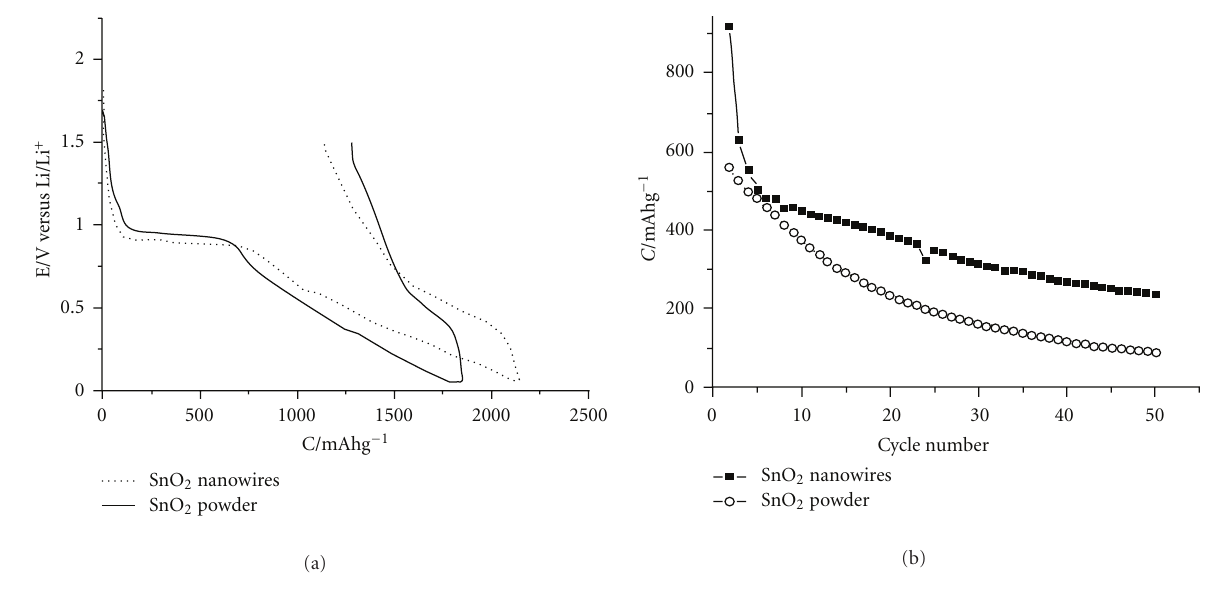
Figure 8: (a) The voltage profile for the first cycle between 0.05 V and 1.5 V compared with pure SnO 2 powder. (b) The cyclic performance from the second cycle to the 50th cycle of SnO 2 nanowires and pure SnO 2